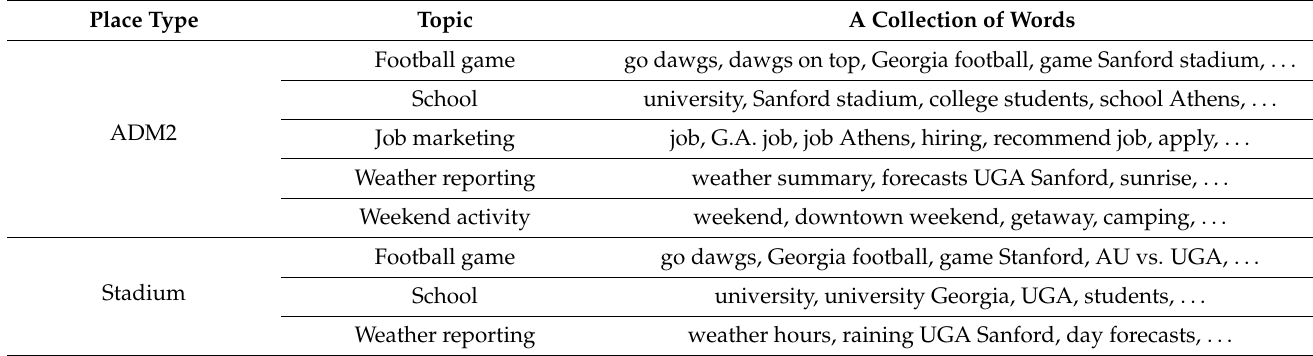
Table 2. Examples of word sets forming topics for the place categories ADM2 and Stadium. Place Type Topic A Collection of